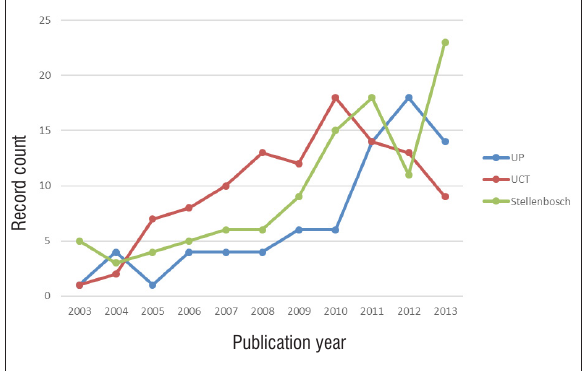
The number of Energy and Fuels articles produced by the Universities of Cape Town (UCT) and Pretoria (UP) and Stellenbosch University during the period